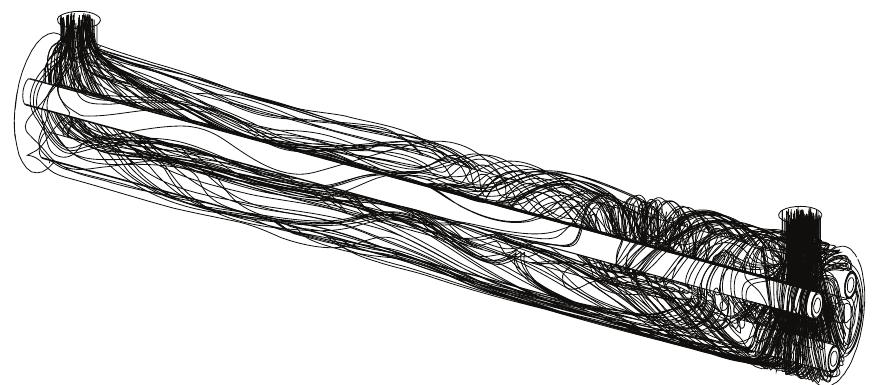
Figure 1: Experimental reactor of the “Svarog” Company. The figure shows motion paths of